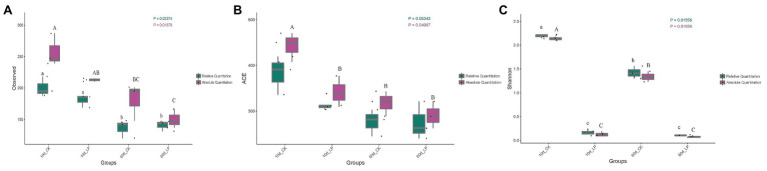
Box-plots of observed bacterial species (A), ACE (B) and Shannon indices (C) of bacterial communities in alfalfa silage. Values with different capital letters indicate significance over groups illustrated by absolute quantification 16S-seq (AQS; p < 0.05). Values with different small letters indicate significance over groups illustrated by Relative quantification 16S-seq (RQS; p < 0.05). CK, control; LP, inoculated with L. plantarum A345. The numbers ahead of CK and LP stand for ensiled days of silage. Observed, observed bacterial species.